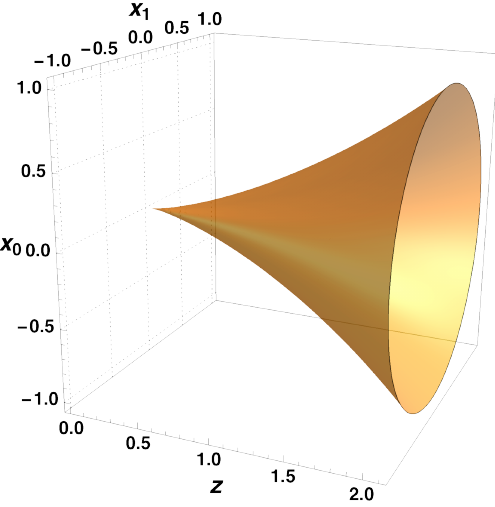
Figure 6 . A 2D contour of the Lagrangian density (3.32) for the 5D meron (multiplied by the volume factor 2 π 2 x 3 ) evaluated at 10. A point-size meron appears at x µ = 0 (where two Euclidean coordinates x 2 , 3 are not shown) which grows in size as z